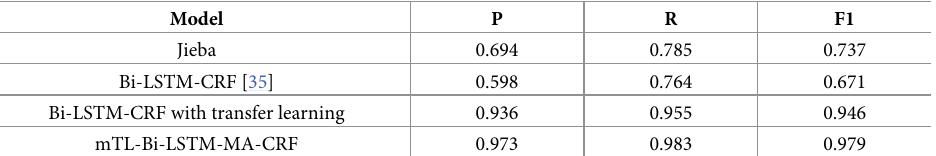
Table 1. Performances of methods.